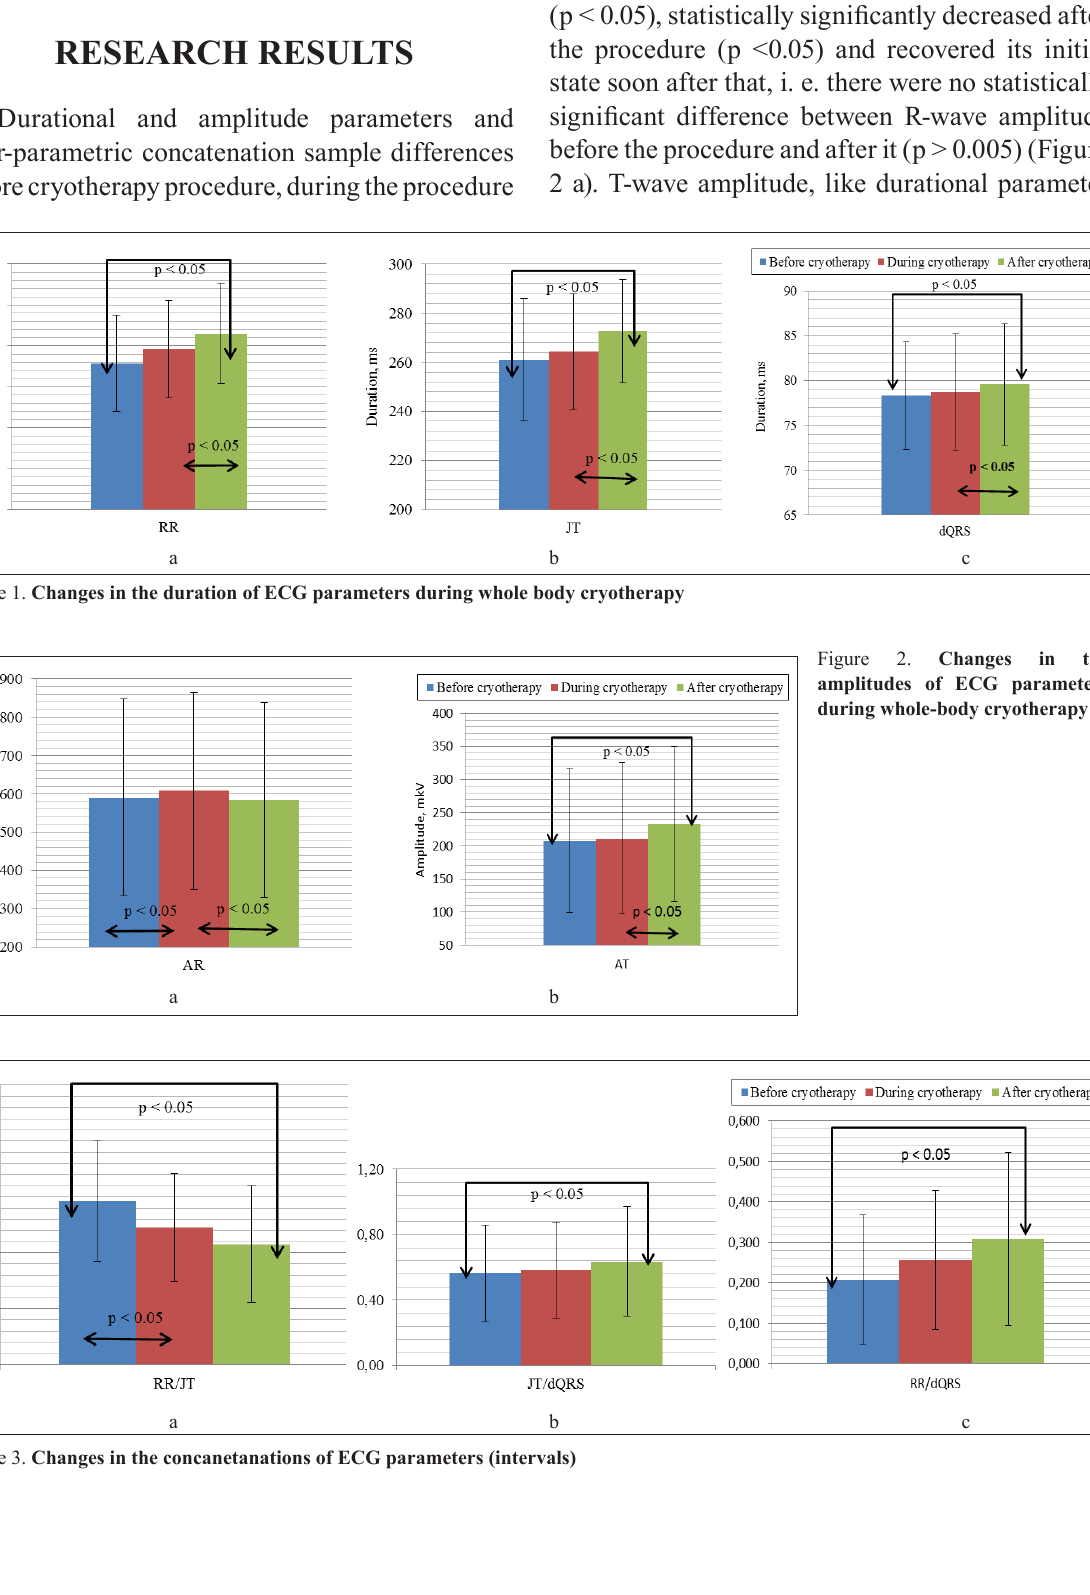
Figure 3. Changes in the concanetanations of ECG parameters (intervals)